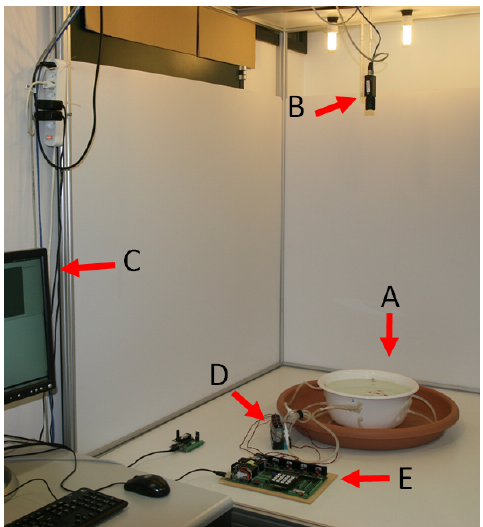
Figure 2. Experimental system, composed of water tank ( A ); overhead camera ( B ); base station desktop ( C ); diaphragm pumps agitating the fluidic environment ( D ); and control and driver board for pumps ( E